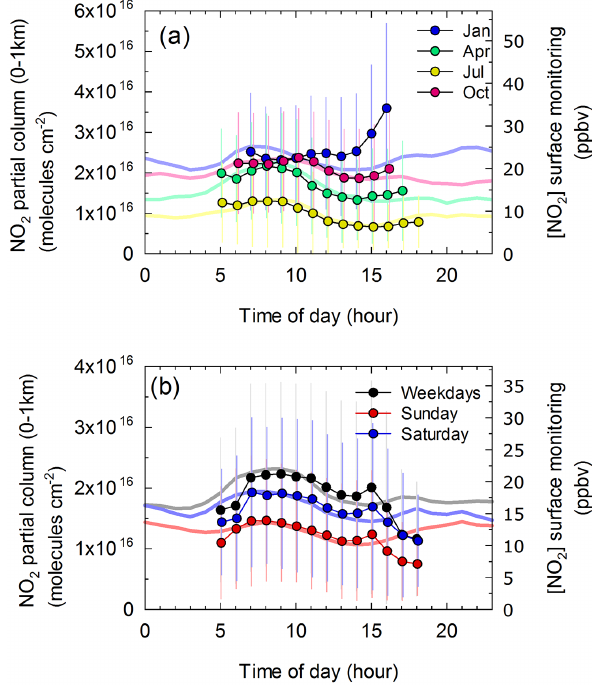
Figure 14. Comparison of average diurnal cycles of NO 2 observed by MAX-DOAS at Yokosuka (partial columns in the lowest 1km layer, colored circles) and by surface monitoring at Nagahama (near Yokosuka, pale colored lines) for (a) four selected months (January, April, July, and October) and for (b) weekdays and weekends. Error bars represent the 1 σ range of the included data